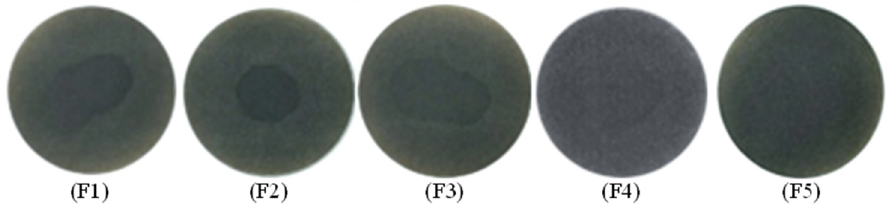
Figure 12. Spot experiment of FCC slurry oil before and after hydrogenation on various catalysts. The feed FCC slurry oil is designated as F1; FCC after reaction with non-catalyst is designated as F2. FCC after reaction with A-MoS 2 is designated as F3; FCC after reaction with M-MoS 2 is designated as F4; FCC after reaction with Mo 2 C is designated as F5.